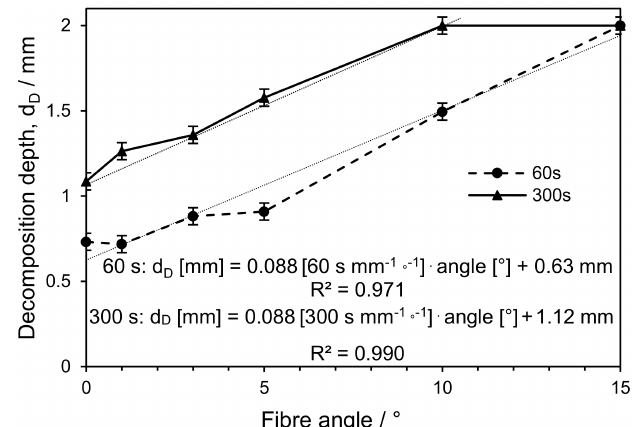
Figure 13. Maximum depth of matrix decomposition determined by µ CT analysis (see Figure 9), and linear regressions for angle-dependent decomposition velocity (see